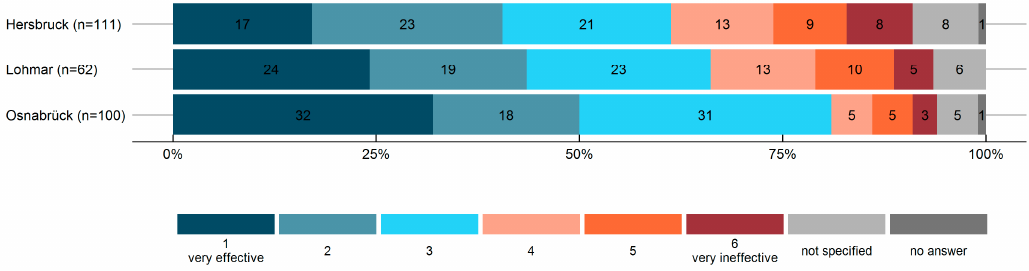
Figure 4. Perceived effectiveness of private precautionary measures for each of the three subsets on a scale from ( 1 ) very effective to ( 6 ) very ineffective. scale from ( 1 ) very effective to ( 6 ) very